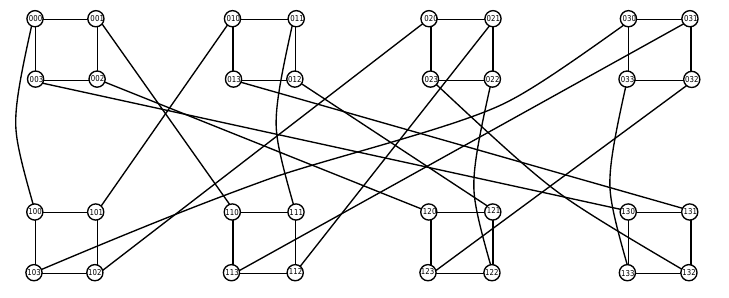
Figure 3: Biswapped network Bsw ( C 4 )